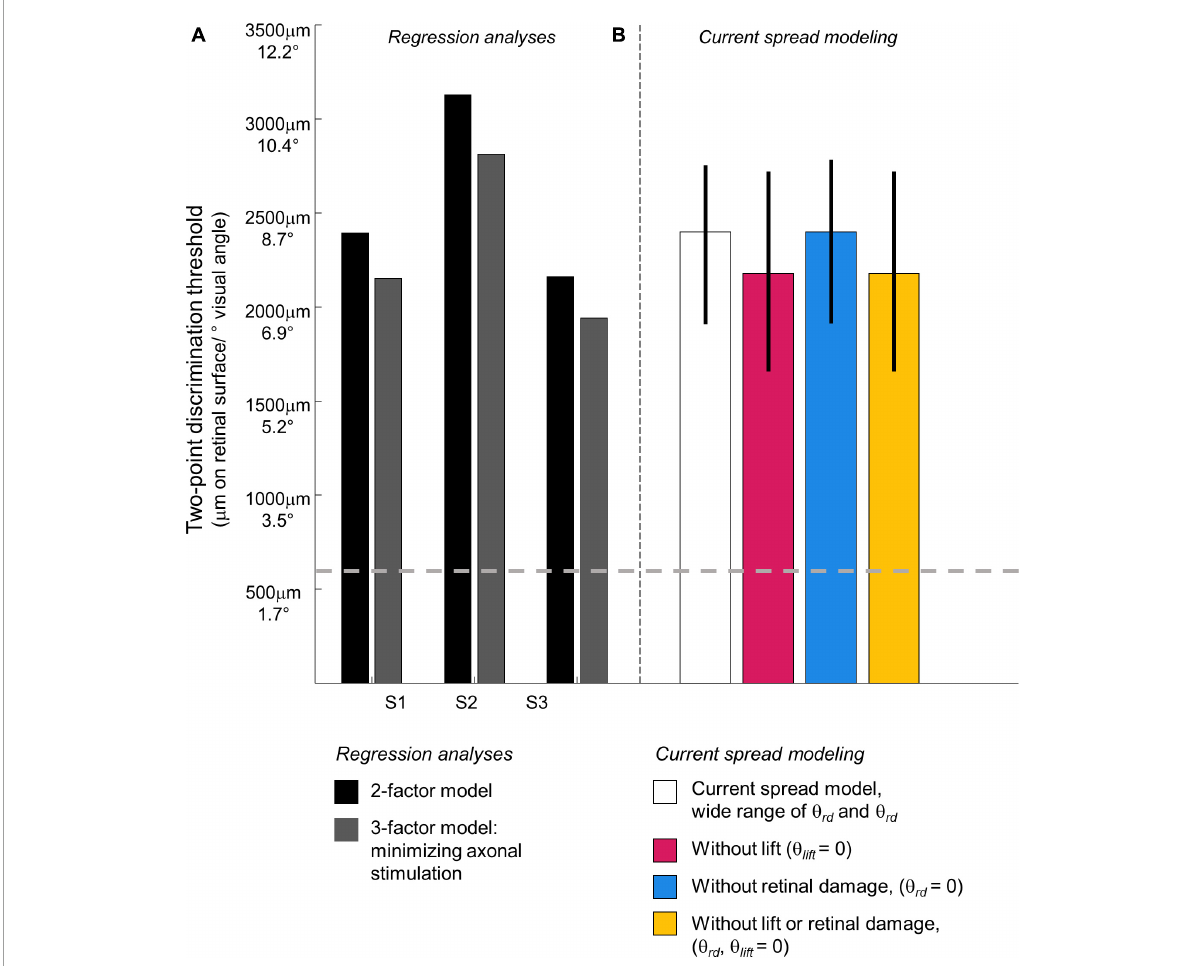
FIGURE7 Predicted two-point discrimination thresholds. The gray dashed line shows the resolution limit (2 ◦ ) that would be obtained if individuals saw two-points when neighboring electrodes were stimulated (Stronks and Dagnelie, 2014). (A) Stage II. Regression analyses. Black bars: The predicted 75% two-point discrimination thresholds with current amplitudes set to each participant’s median current amplitude detection threshold; Gray bars: The predicted 75% two-point detection thresholds if axonal stimulation is minimized. (B) Stage III. Current spread modeling. Empty bar: Predicted 75% two-point discrimination thresholds across the full range of simulation parameterizations that could predict the iso-performance contour predicted by regression analyses; Blue bar: Predicted 75% two-point discrimination thresholds with no retinal damage ( θ rd = 0); Pink bar: Predicted 75% two-point discrimination thresholds with the electrode flush to the retinal surface ( θ list = 0); Yellow bar: Predicted 75% two-point discrimination thresholds with no retinal damage and the electrode flush to the retinal surface ( θ rd , θ list = 0). Error bars represent the 5–95% confidence range of simulation